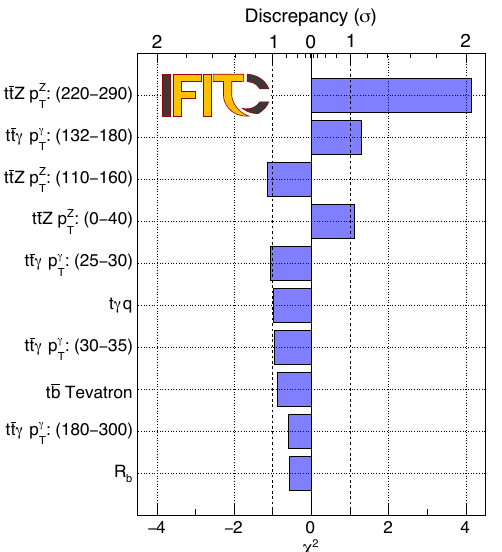
Figure 1 . Contributions to the χ 2 of some of the input measurements, together with their SM discrepancy with respect to the SM predictions. The full fit has 30 data points and a cumulative χ 2 ∼ 21 . 3 . The negative values indicate that the prediction is lower than the measurement. Both SM theoretical and experimental uncertainties are